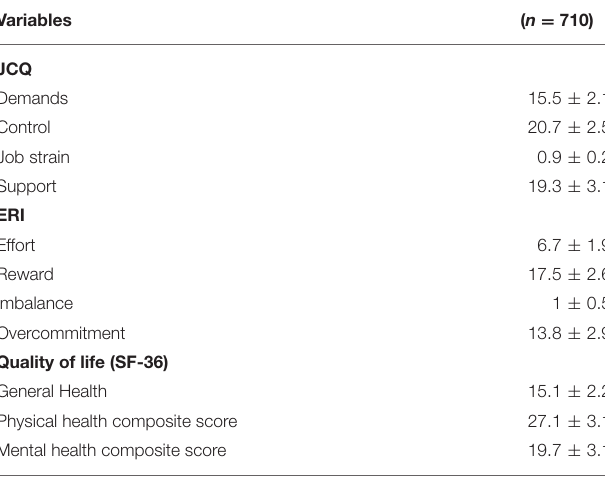
TABLE 2 | Psychological stress evaluation and quality of